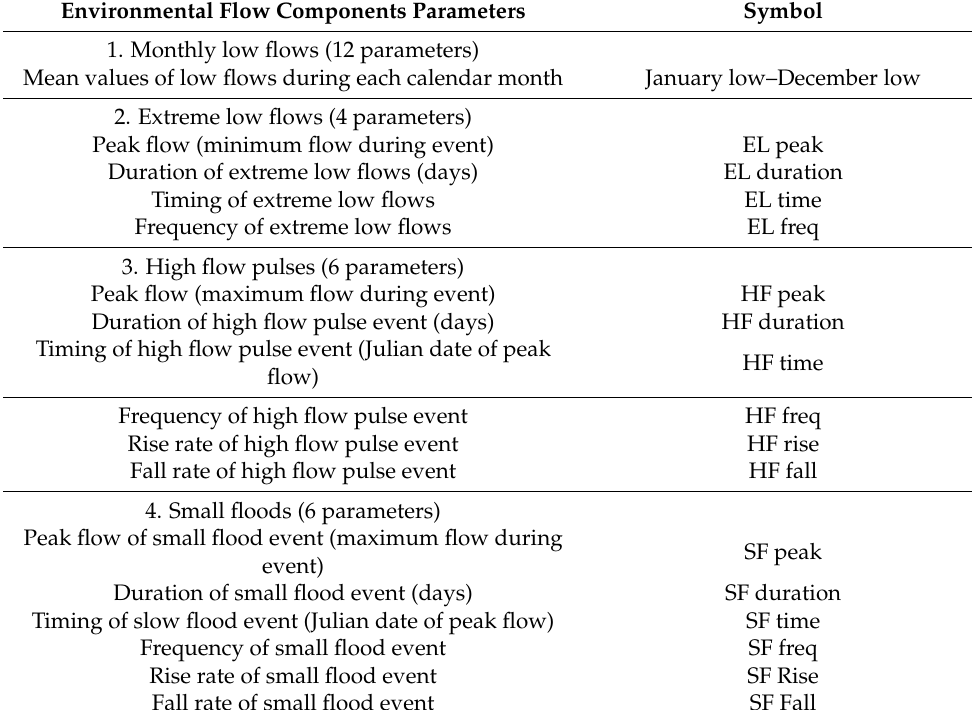
Table 3. List of 34 Environmental Flow Component (EFC) parameters that adopted in this